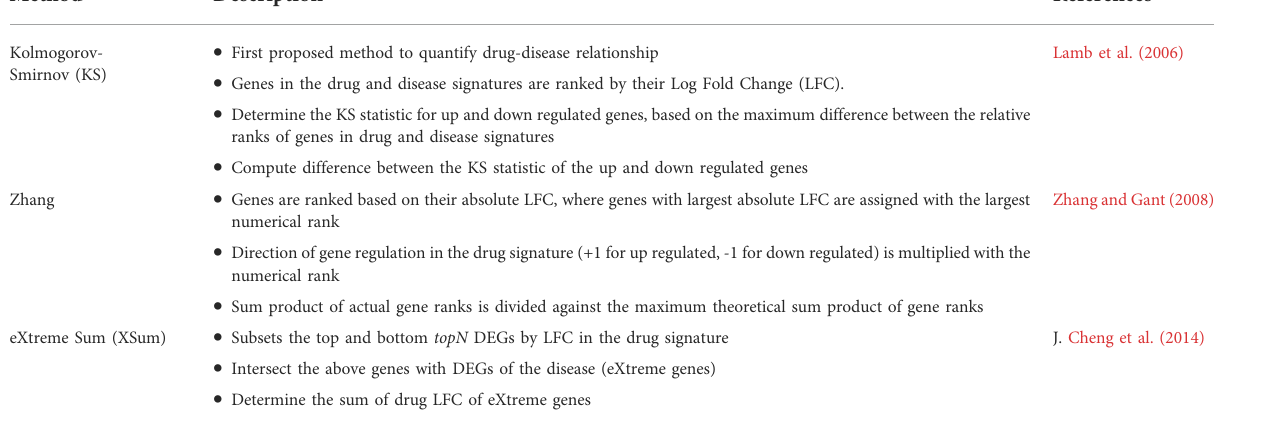
TABLE 2 Brief description of current drug-disease algorithms that are evaluated in this study.